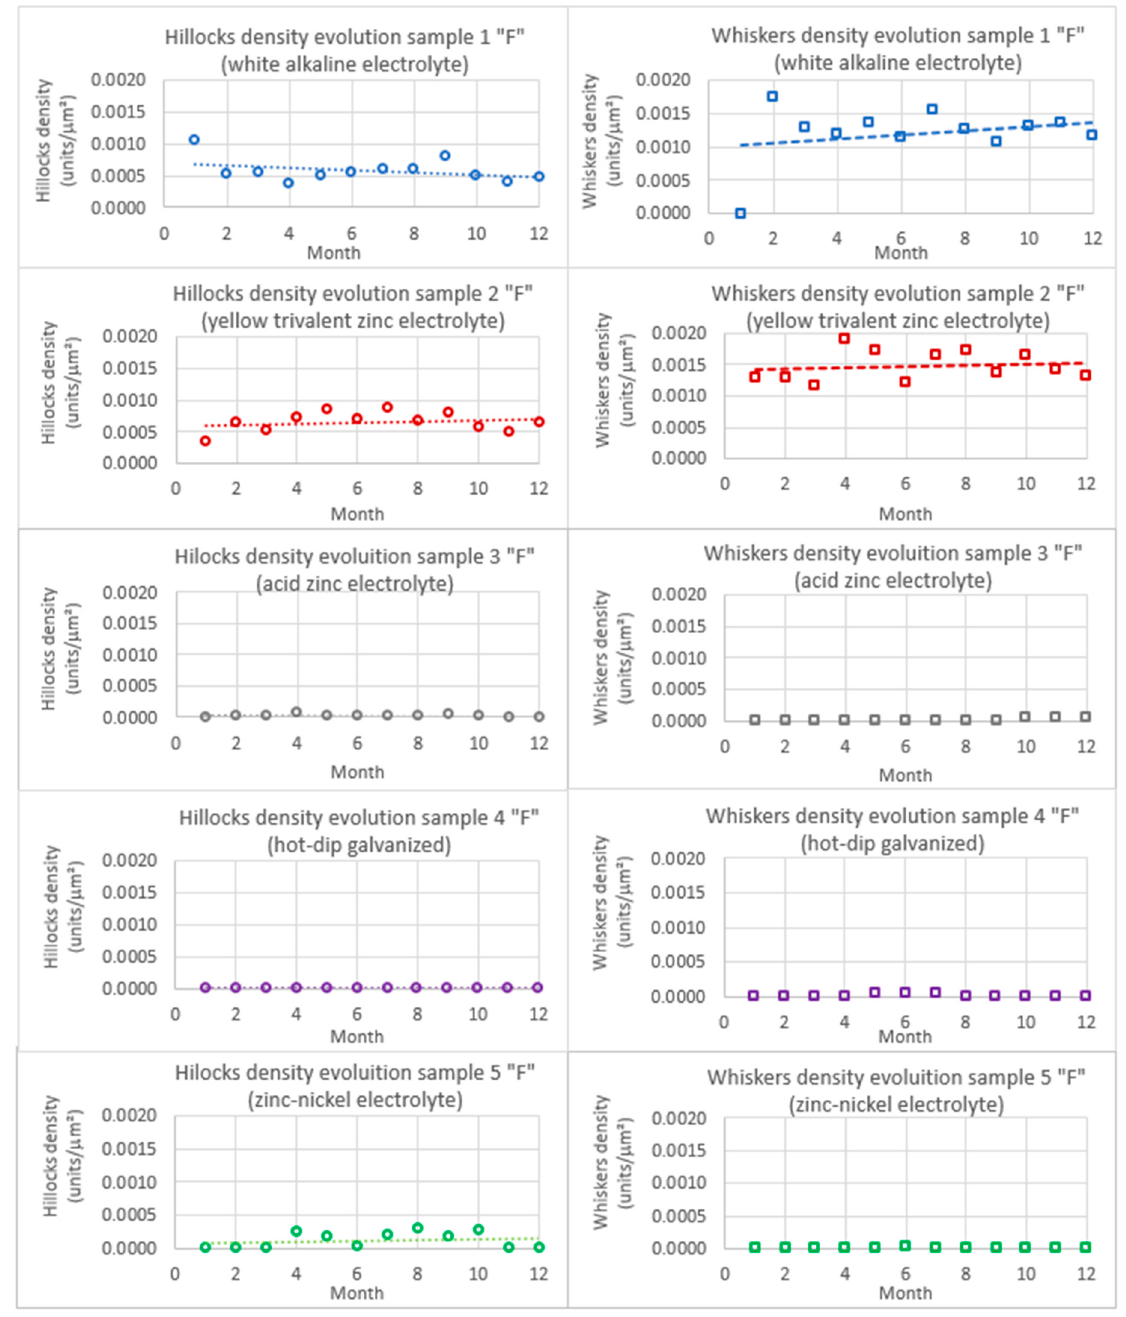
Figure 15. Evolution of hillocks and whiskers in compression stressed samples by bending “F”. In sample 3 (acid zinc electrolyte coating), no hillocks or whisker progression were no- ticed during the first 8 months. However, traces of the beginnings of whisker growth were encountered in months 9 to 12, although their density was negligible (5 × 10 − 5 whiskers/ µ m 2 ), so no tendency could be established. In this case, the com- pression bending stress effect observed in samples 1 (white alkaline electrolyte) and 2 (yellow trivalent zinc electrolyte) that favors whisker growth was not present. In fact, the whisker growth after 8 months was higher in the effort-less samples, but given the presence of this effect at the end of the study, further conclusions should not be made regarding this matter in coating